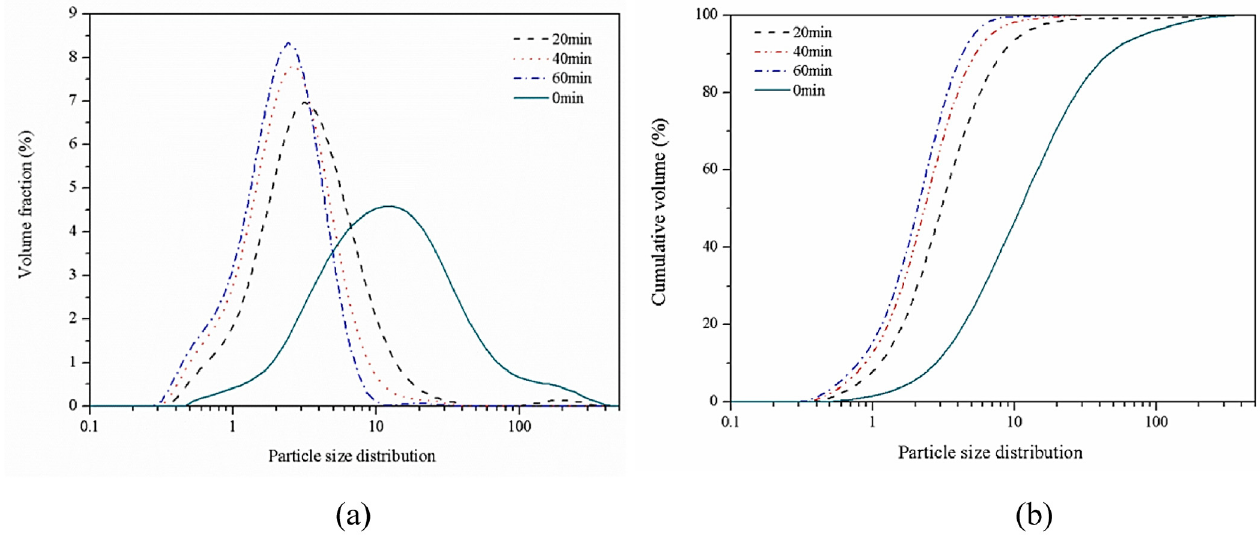
Figure 6. The particle size distribution (µm) of CSW ( a ) volume fraction (%) and ( b ) cumulative volume (%) with respect to grinding duration [169].